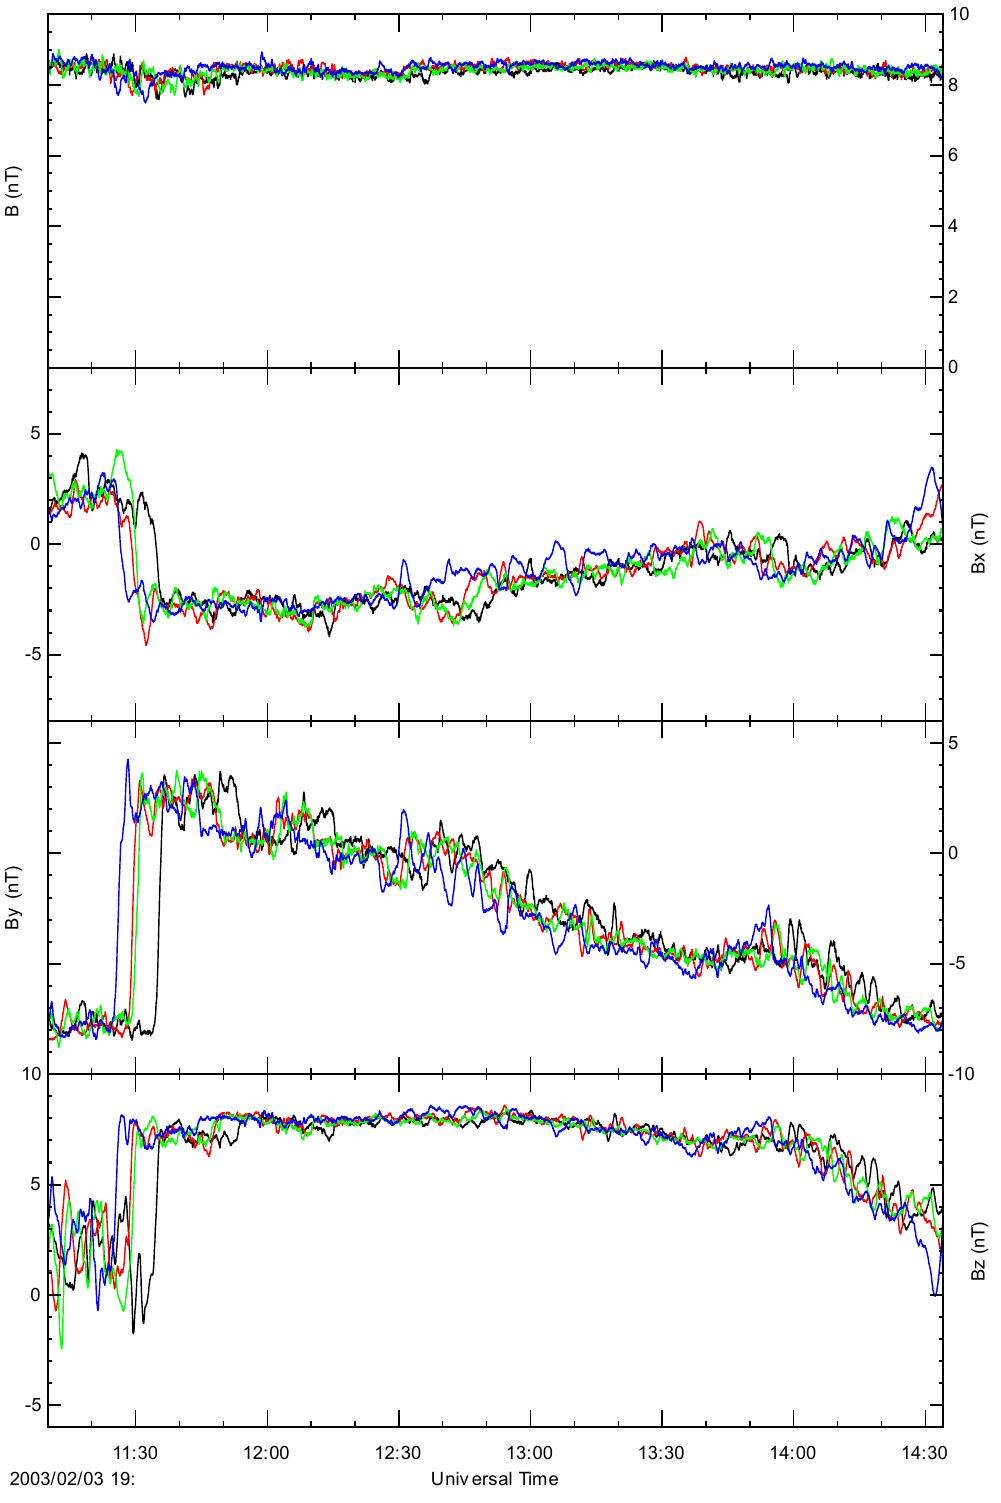
Fig. 7. Cluster event on 3 February 2003: Time plots of GSE magnetic field components, measured by each of the four spacecraft (C1 black; C2 red; C3 green; C4 blue). Resolution is 22.4